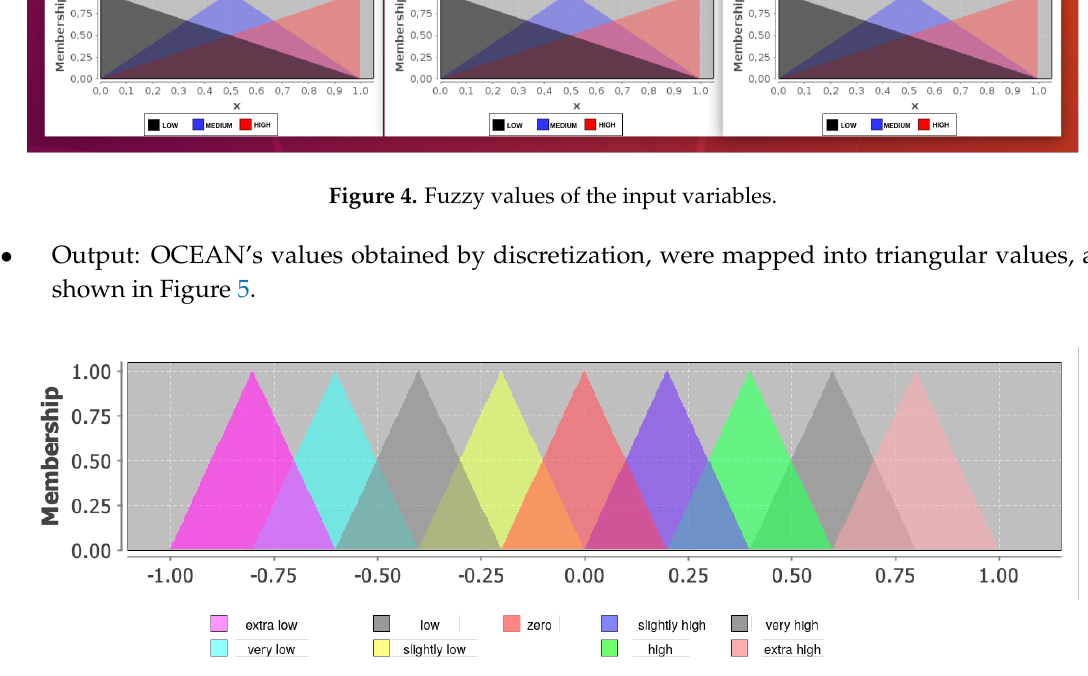
Figure 5. Fuzzy values of the output variables.